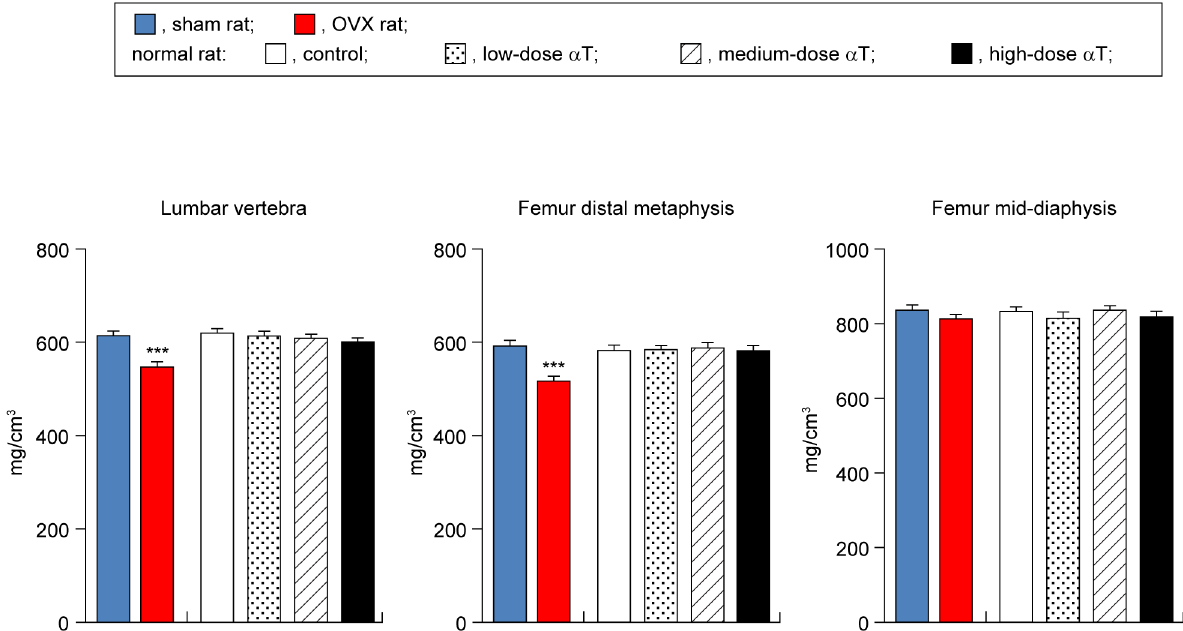
Fig 1. α T supplementation effects on bone mineral density of lumbar vertebra and femur in normal rats. Data are presented as mean ± standard error of the mean. *** P < 0.001 vs. sham rat group.